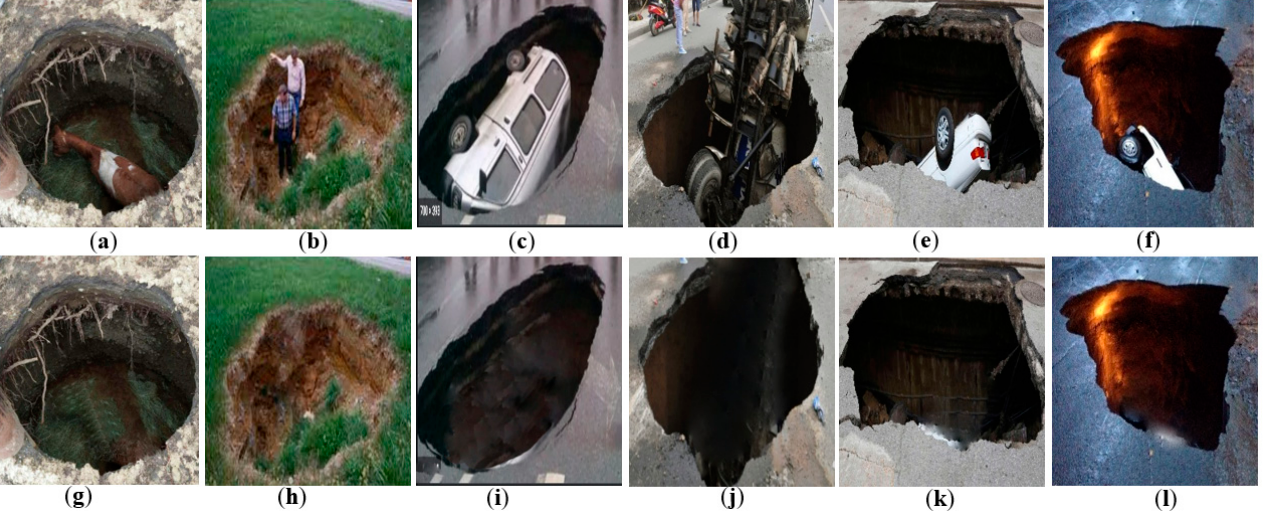
Figure 5. The first row ( a – f ) shows the collected raw sample images, while the second row ( g – l ) shows the corresponding preprocessed and curated sample images. The corresponding curated image of the raw sample ( a ) is given in the sample column ( g ).